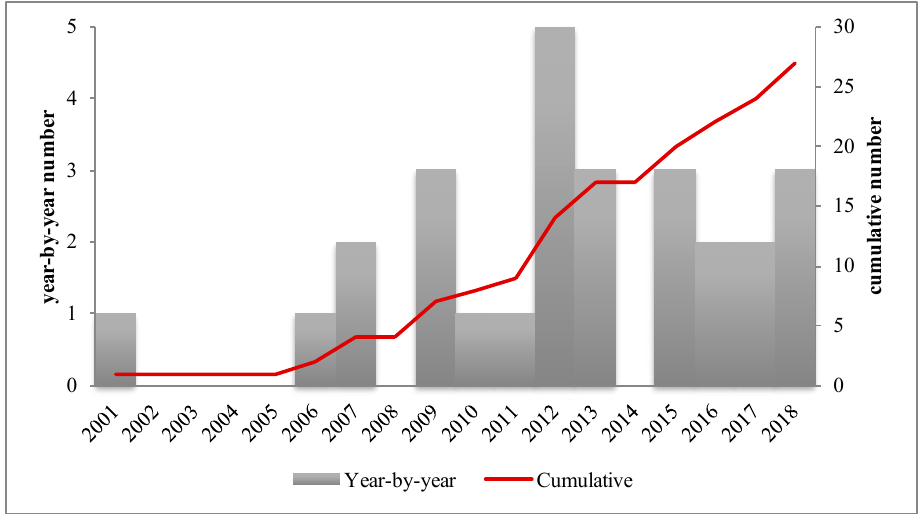
Figure 2. Evolution of the literature on